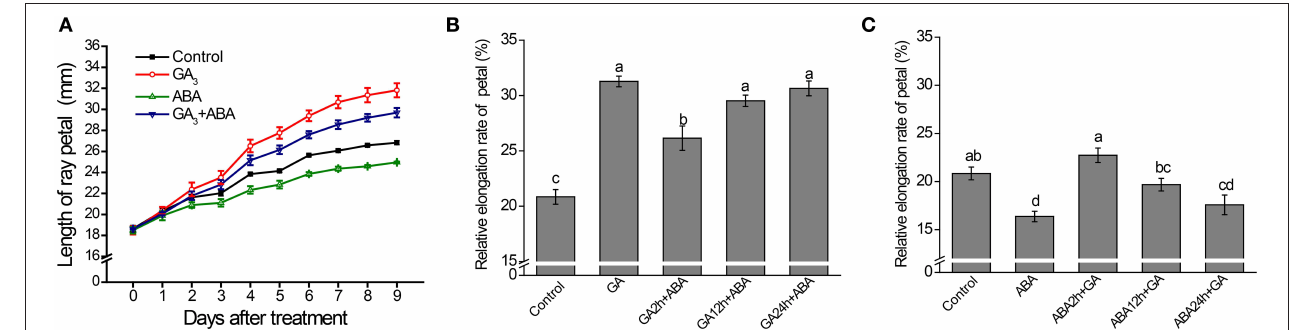
FIGURE 2 | Effects of GAor ABA on petal growth are attenuated by co-application of the hormones. Petals of inflorescences at stage 3 were detached and placed on filter paper soaked with 3% sucrose (Control) or with hormone supplementation and were cultured as described in the text. (A) Time-course dynamics of petal length under control conditions or after treatment with 10 µ M GA 3 , 50 µ M ABA or a mixture of 10 µ M GA 3 and 50 µ M ABA. A total of 10 petals for each treatment were cultured for 9 days. (B) Effect on petal elongation rate of addition of ABA after pre-culture with GA alone for 2, 12, and 24h. (C) Effect on petal elongation rate of addition of GA after pre-culture with ABA alone for 2, 12, and 24h. Petals were cultured for a total